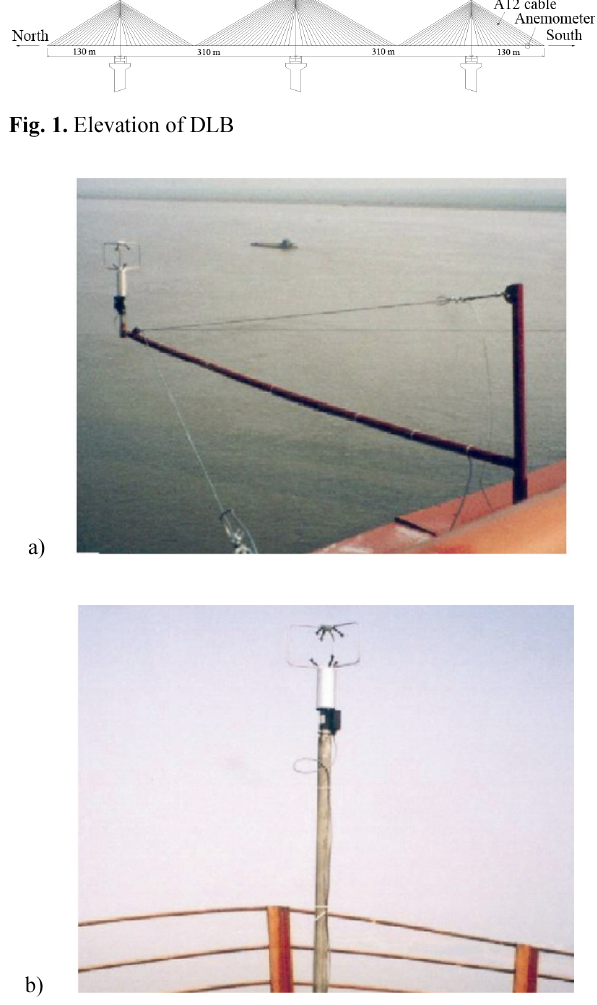
Fig. 2. Ultrasonic anemometers installation for field measure- ment: (a) anemometer at deck level; (b) anemometer at south side tower